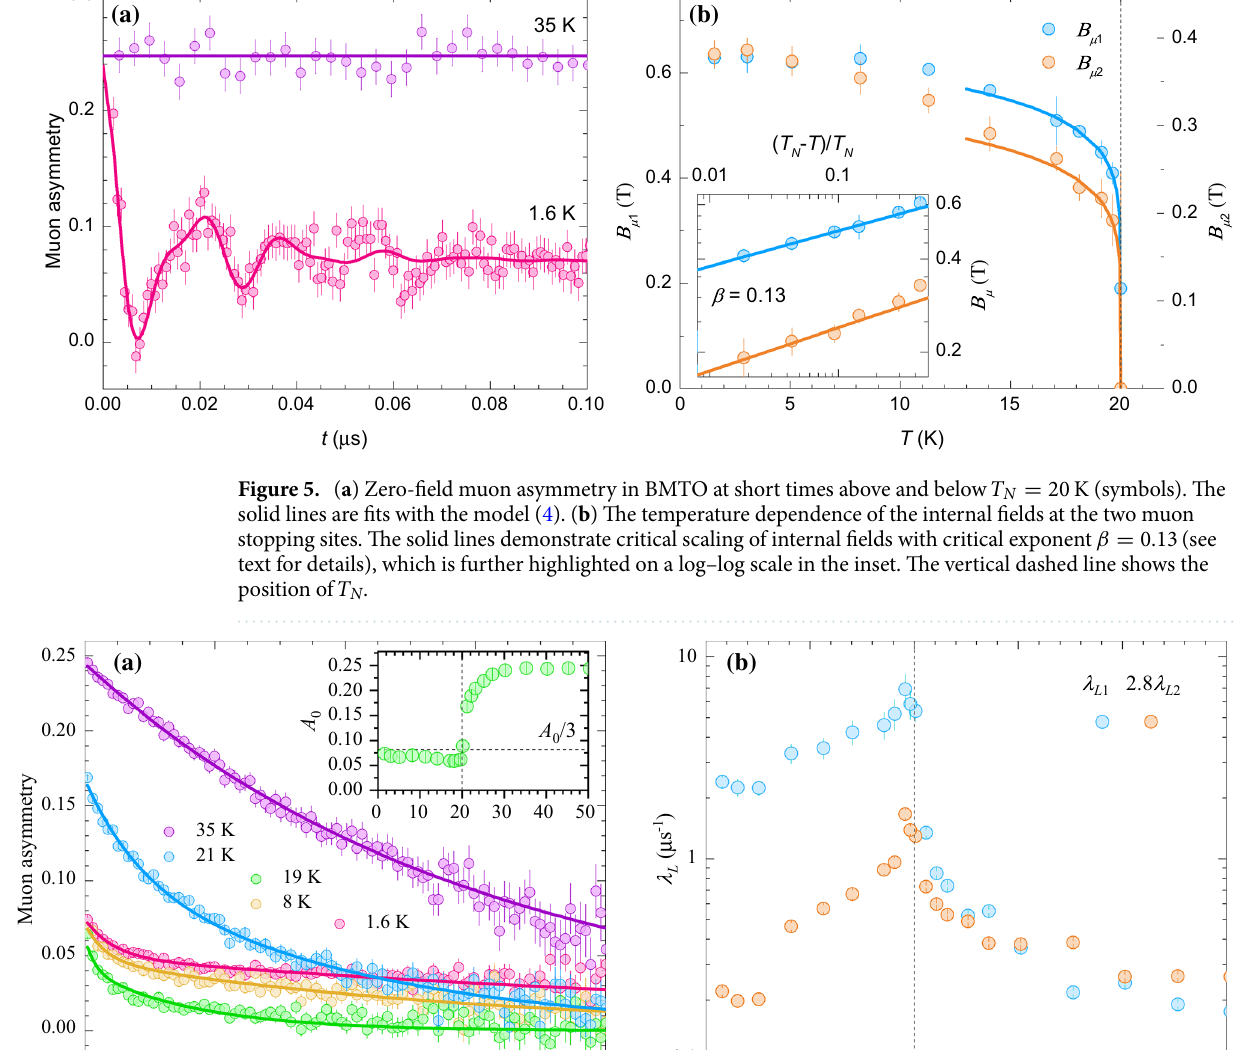
Figure 6. ( a ) Zero-field muon asymmetry in BMTO at various temperatures (symbols). The inset shown the initial asymmetry of the non-oscillating signal. The solid lines are fits with the model (5). ( b ) The temperature dependence of the longitudinal muon spin relaxation rates at the two muon stopping sites in BMTO. The vertical dashed line shows the position of T N